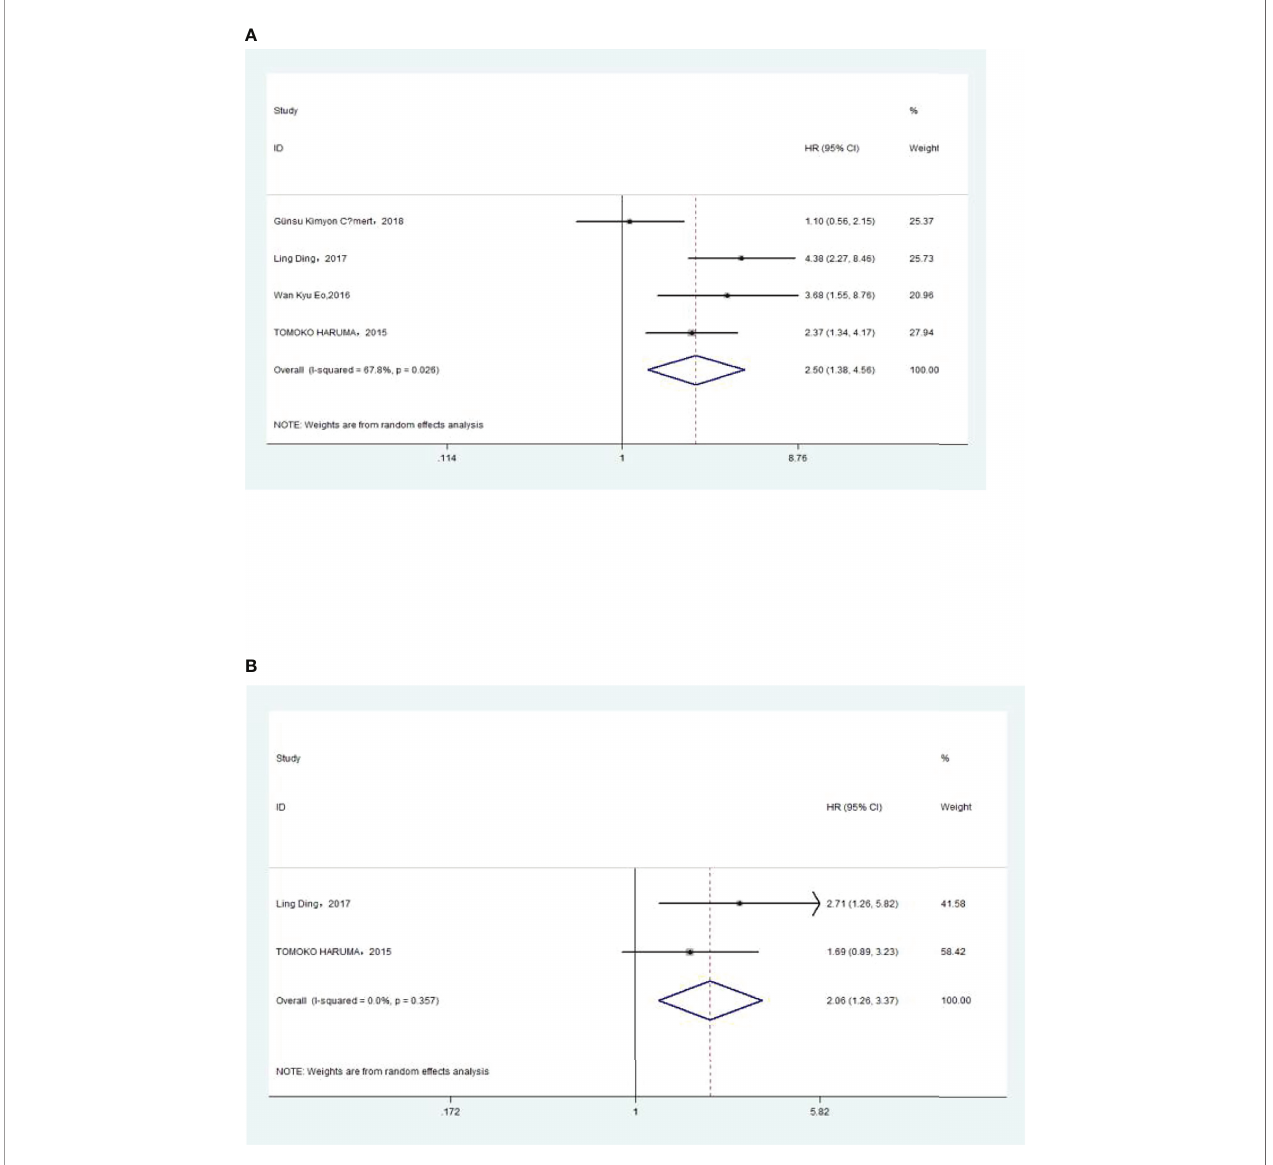
FIGURE 3 | (A) Relationship between neutrophil – lymphocyte ratio (NLR) and disease-free survival (DFS) in univariate analysis. (B) Relationship between NLR and DFS in multivariate